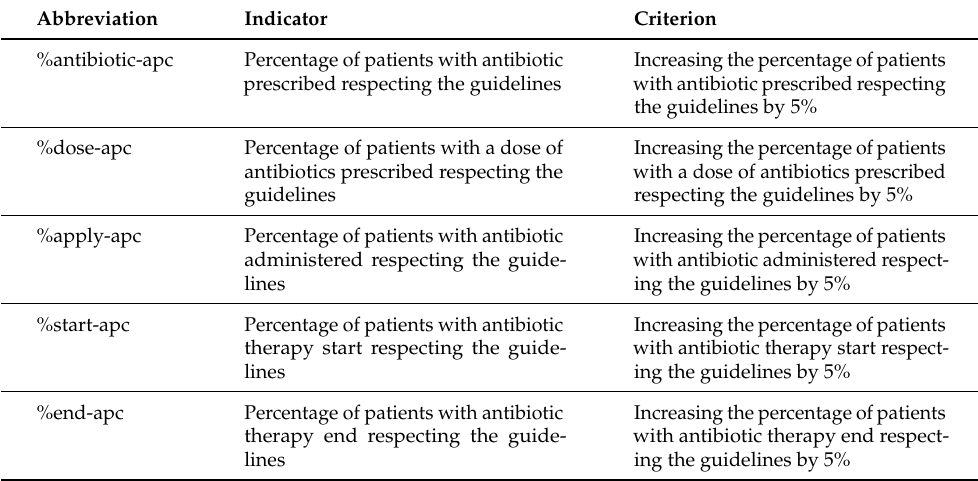
Table 9. Indicators and criteria for the antimicrobial prophylaxis in colorectal surgery (APC).